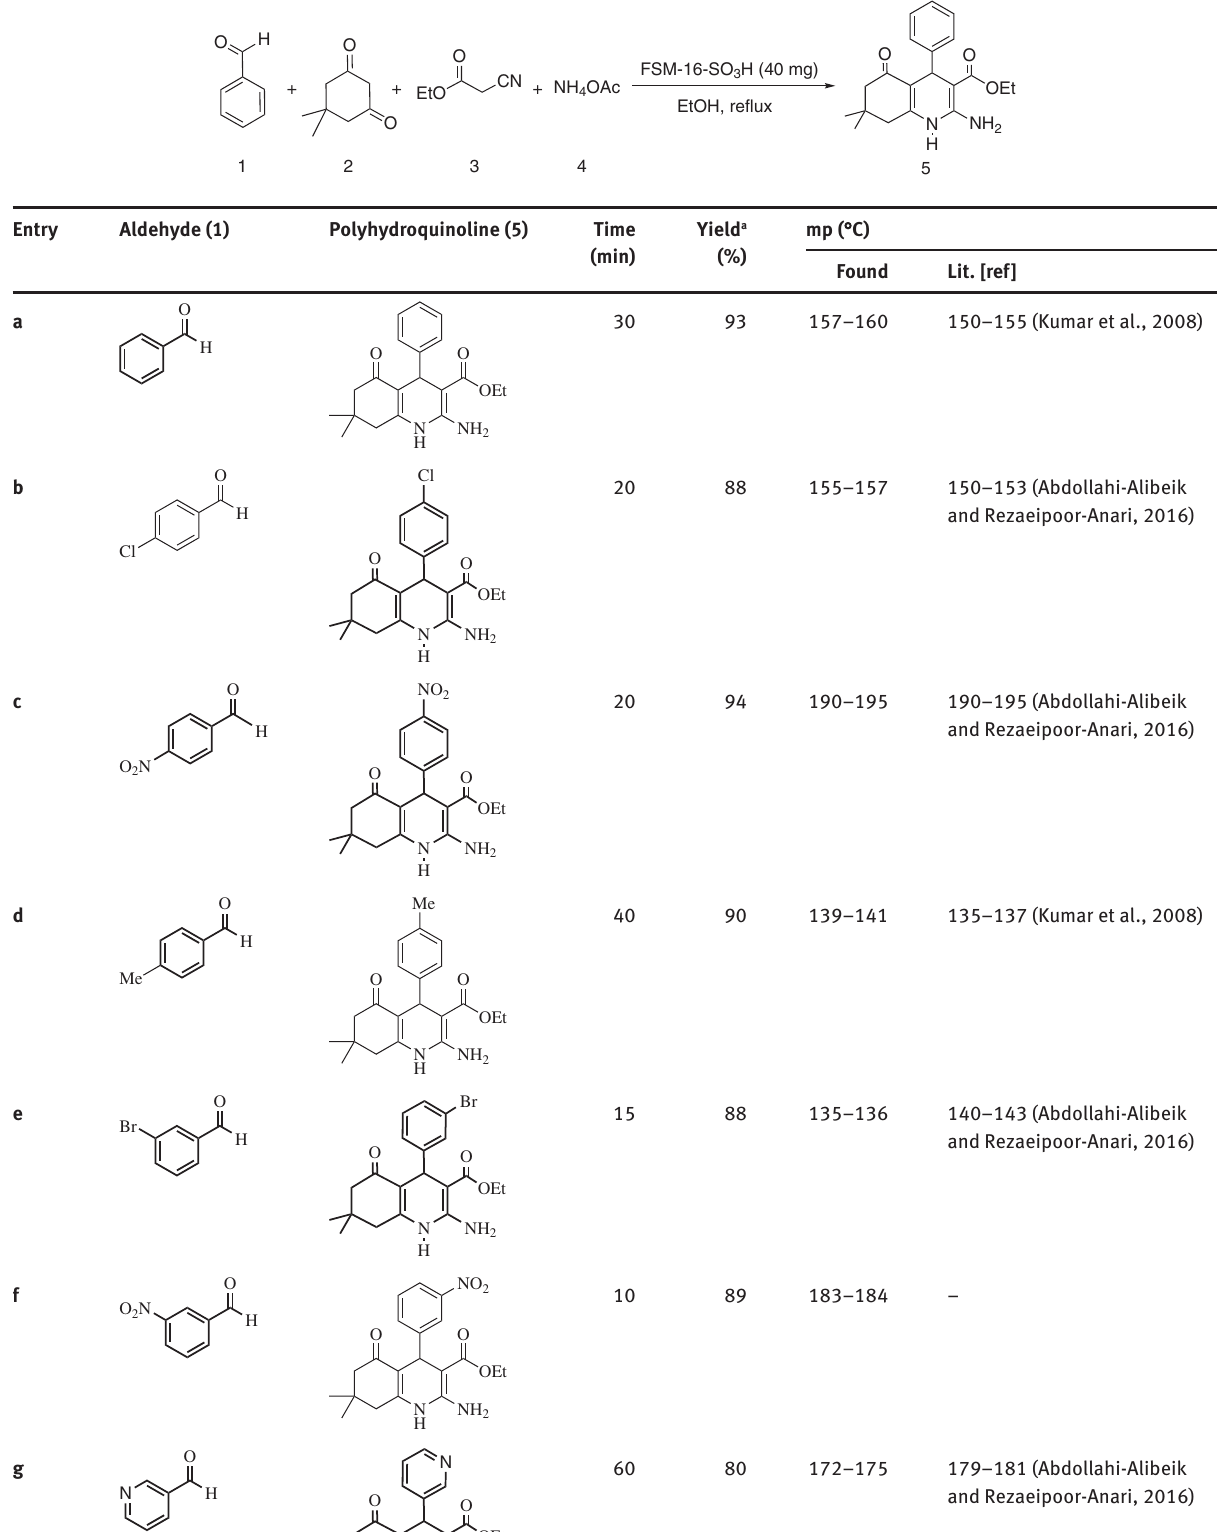
Table 3: Synthesis of polyhydroquinolines in the presence of FSM-16-SO